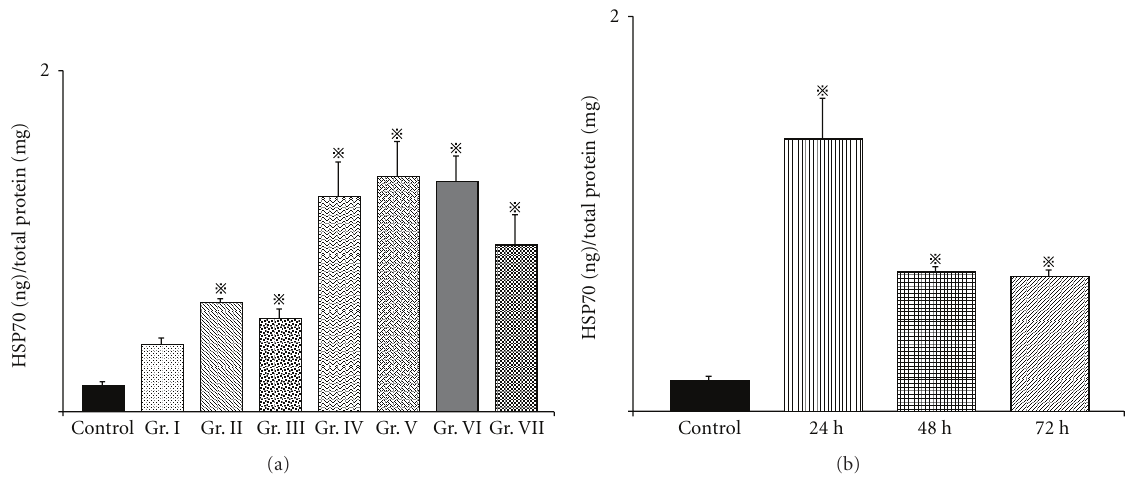
Figure 7: Expression of HSP70 in a tumor after thermotherapy. (a) Amounts of HSP70 in tumors 24 hours after thermotherapy as described in the Materials and Methods. All data are presented as mean ± standard deviation ( n = 4). There were significant di ff erences between the control group and all other groups except Group I by Dunnett’s test ( P < . 05). (b) Amounts of HSP70 24, 48, and 72 hours after thermotherapy at 43 ◦ C for 30 minutes. All data are presented as mean ± standard deviation ( n = 4). There were significant di ff erences between the control group and all other groups by Dunnett’s test ( P < . 05).